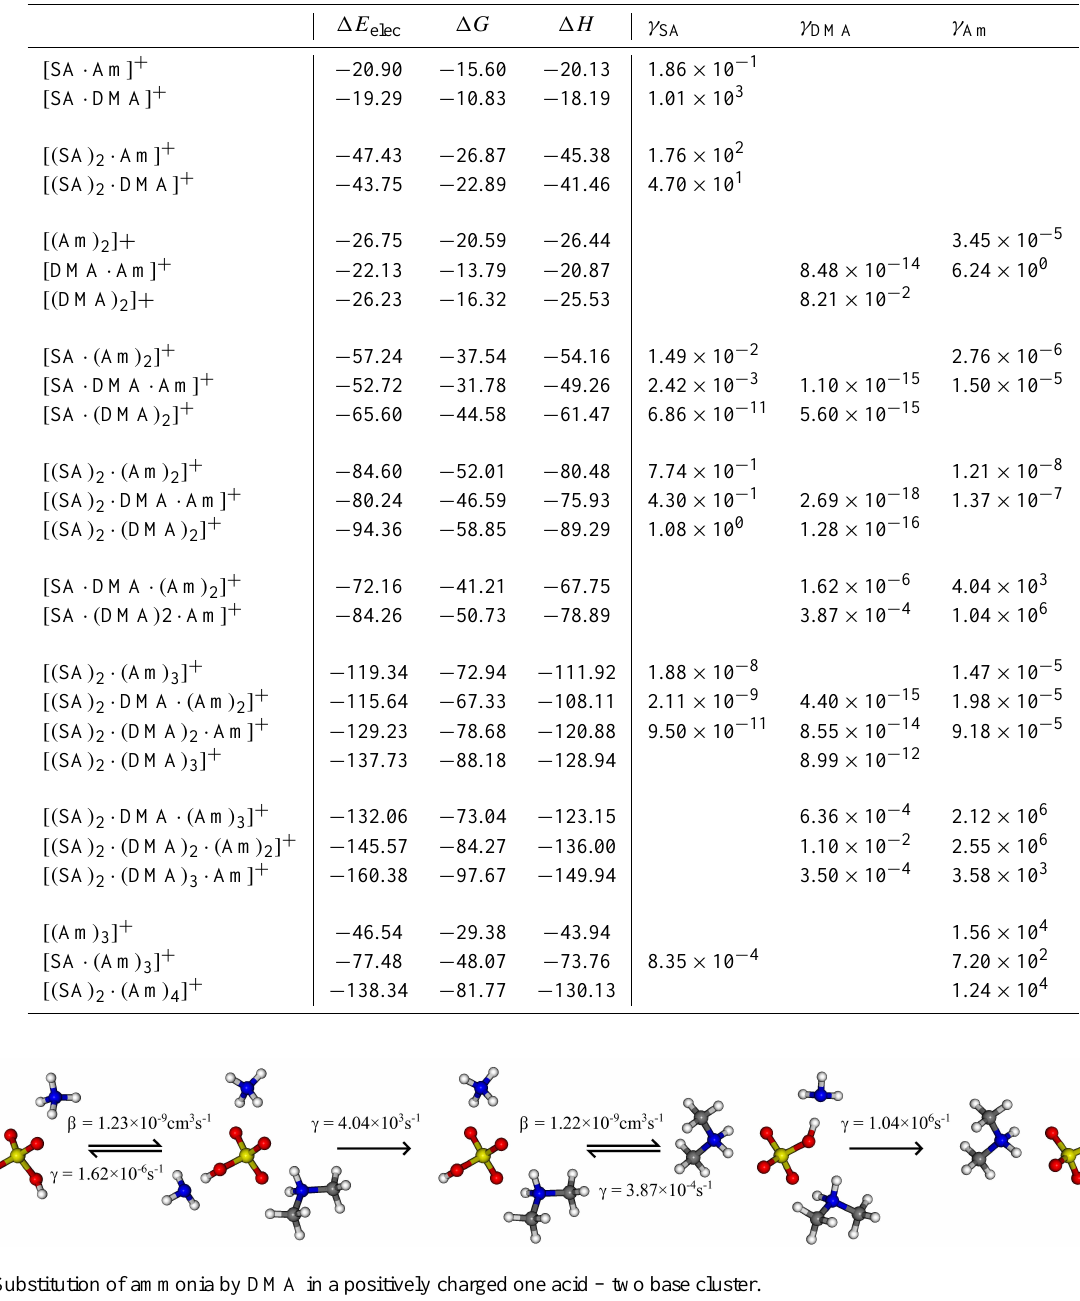
Table 2. Formation free energies (kcalmol − 1 ) and monomer evaporation rates (s − 1 ) of charged sulfuric acid (SA) – ammonia (Am) – dimethylamine (DMA) clusters.